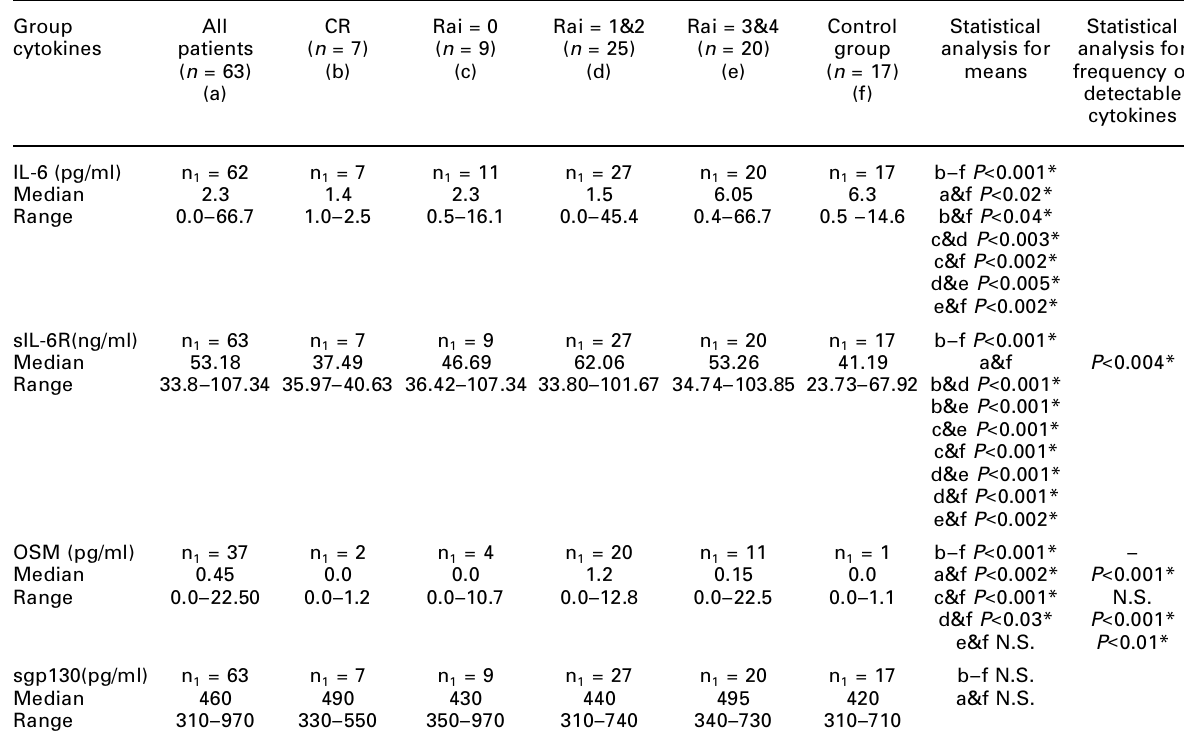
Table 4. Serum levels of IL-6, OSM, sIL-6R and sgp130 in patients with CLL by Rai stage and in normal control group. Median and range in parentheses. Group cytokines